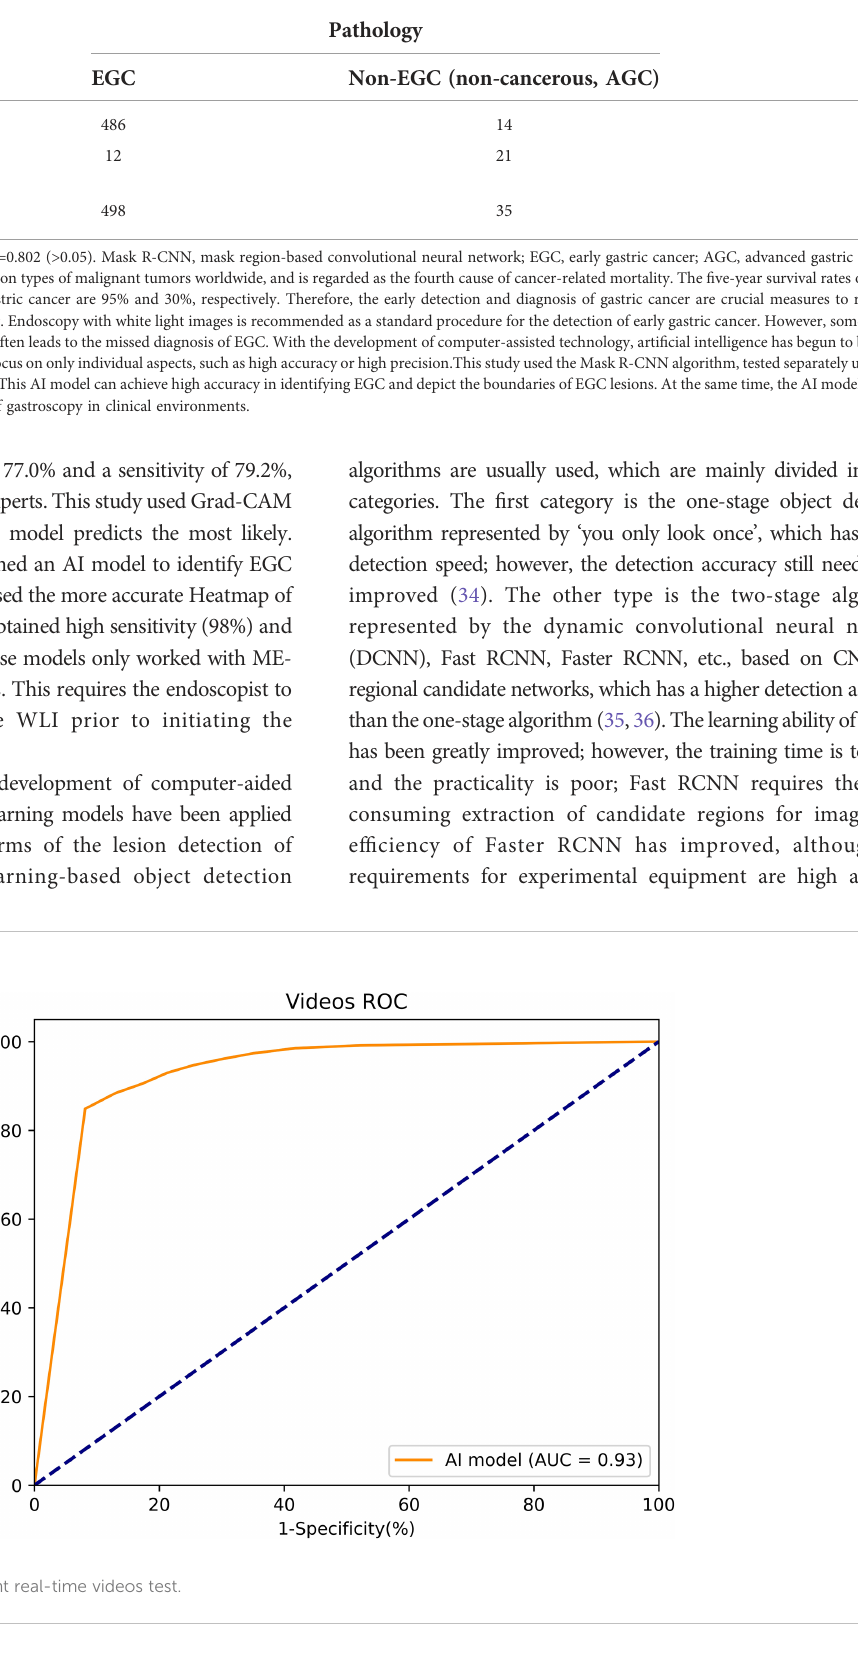
TABLE 3 Performance of the Mask R-CNN system in narrow band images.